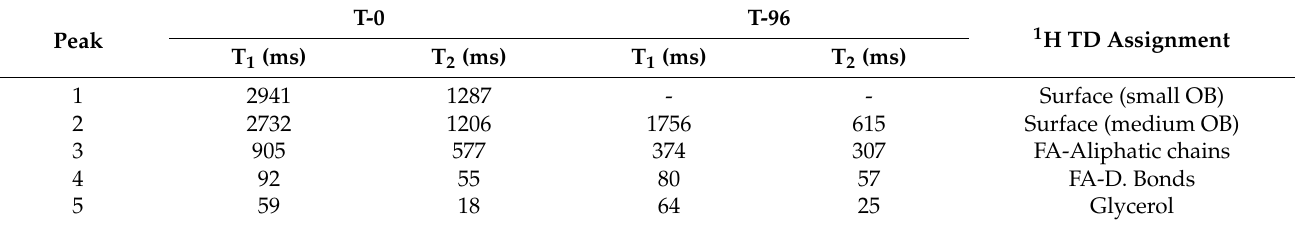
Table 3. Numerical values of T 1 -T 2 of LSE and proposed 1 H TD assignment.